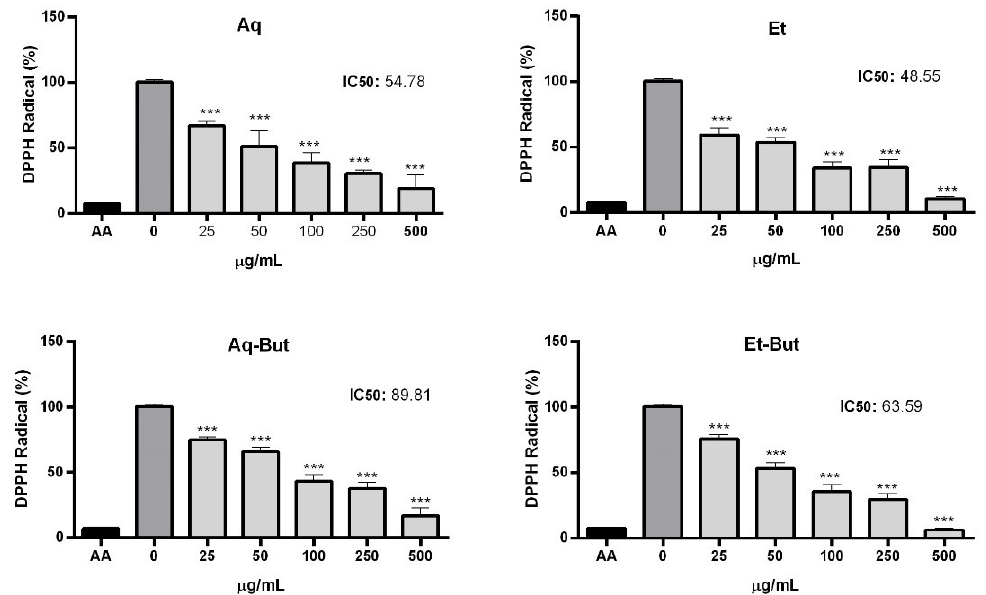
Figure 5. Analysis of the antioxidant effects of M. albicans extracts on DPPH radical scavenging. Aqueous (Aq) and ethanol (Et) extracts, as well as their n -butanol fractions (Aq-But, Et-But), were tested at 25–500 µg/mL. 0: negative control (vehicle). AA: positive control (ascorbic acid). Statistical analyses were performed by one-way analysis of variance (ANOVA), followed by Bonferroni’s test, for selected pairs. Results represent the mean ± SD of two independent experiments ( n = 2, in triplicate); *** p < 0.001.